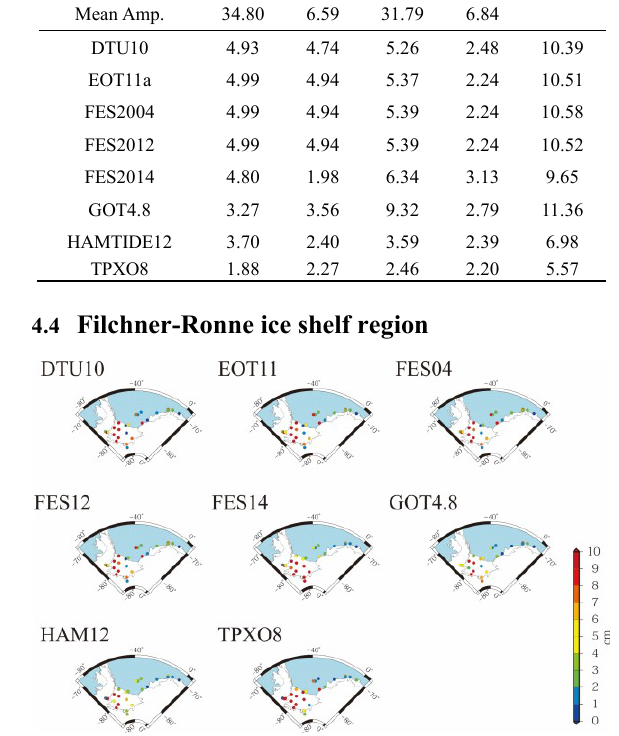
Figure 9. The same with Figure 6 but for Filchner-Ronne ice shelf region. This region has the worst performance in all four regions. Most large vector differences are located in the west of the ice shelf, near the grounding